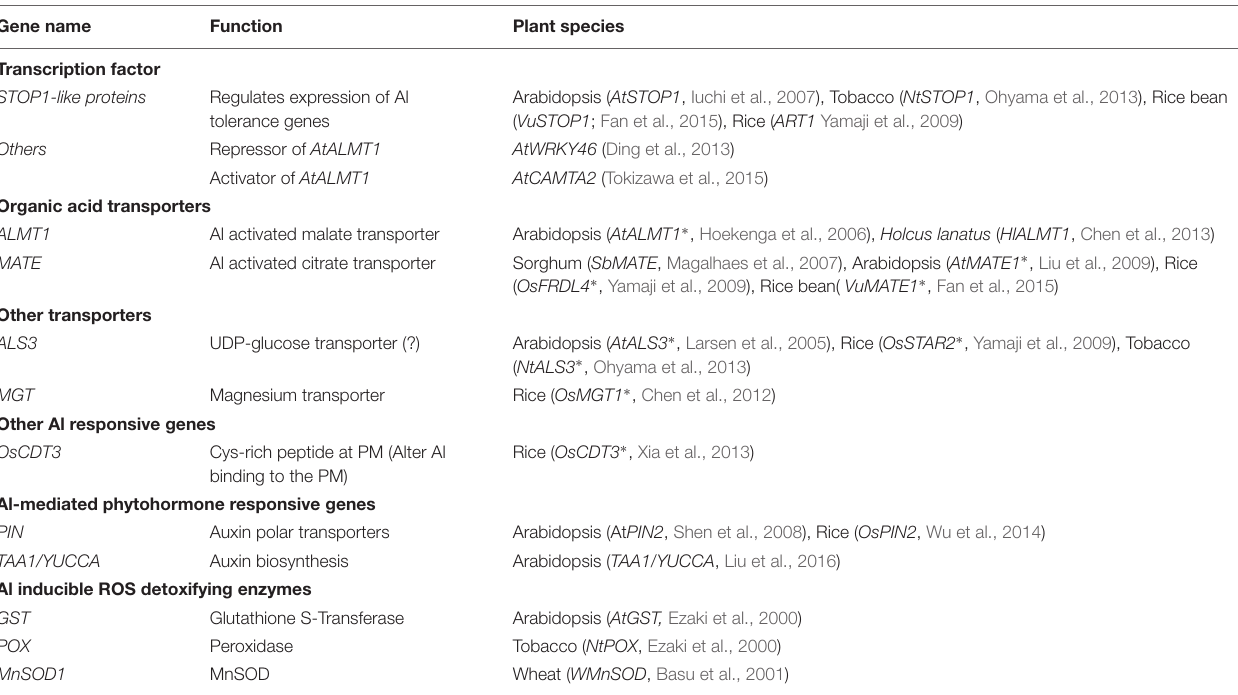
TABLE 1 | Summary of transcriptionally regulated Al tolerance genes, and their regulatory genes mediating Al, phytohormone and reactive oxygen species